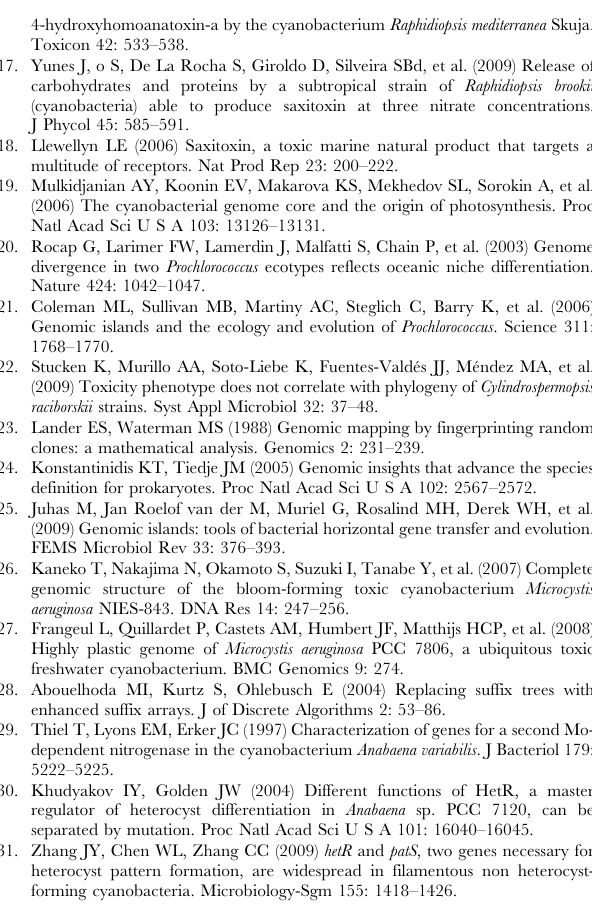
Table S4 83 Previously described regulatory genes present in the genomes of the terminal heterocystous cyanobacteria C.